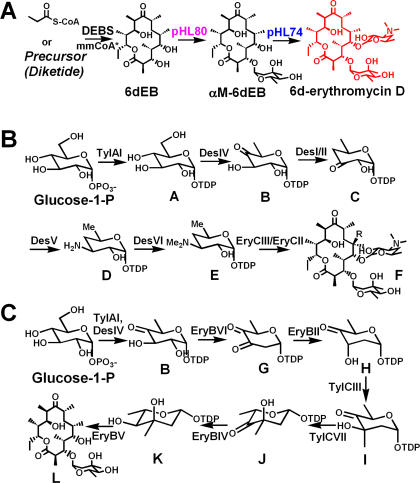
Production of 6d-EryD in E. coli
(A) Biosynthesis of 6d-EryD in E. coli BAP1. (*mmCoA, methylmalonyl-CoA).(B) Reconstitution of the TDP-desosamine biosynthesis and transfer pathway (pHL74, pHL50). A, TDP-D-glucose; B, TDP-4-keto-6-deoxy-D-glucose; C, TDP-3-keto-4,6-dideoxy-D-glucose; D, TDP-3-amino-4,6-dideoxy-D-glucose; E, TDP-D-desosamine; F, R = OH, erythromycin D, R = H, 6-deoxyerythromycin D.(C) Reconstitution of the TDP-mycarose biosynthesis and transfer pathway (pHL80, pHL71). G, TDP-3,4-diketo-2,6-dideoxy-D-glucose; H, TDP-4-keto-2,6-dideoxy-D-glucose; I, TDP-4-keto-3-methyl-2,6-dideoxy-D-glucose; J, TDP-4-keto-3-methyl-2,6-dideoxy-L-glucose; K, TDP–L-mycarose; L, αMEB.